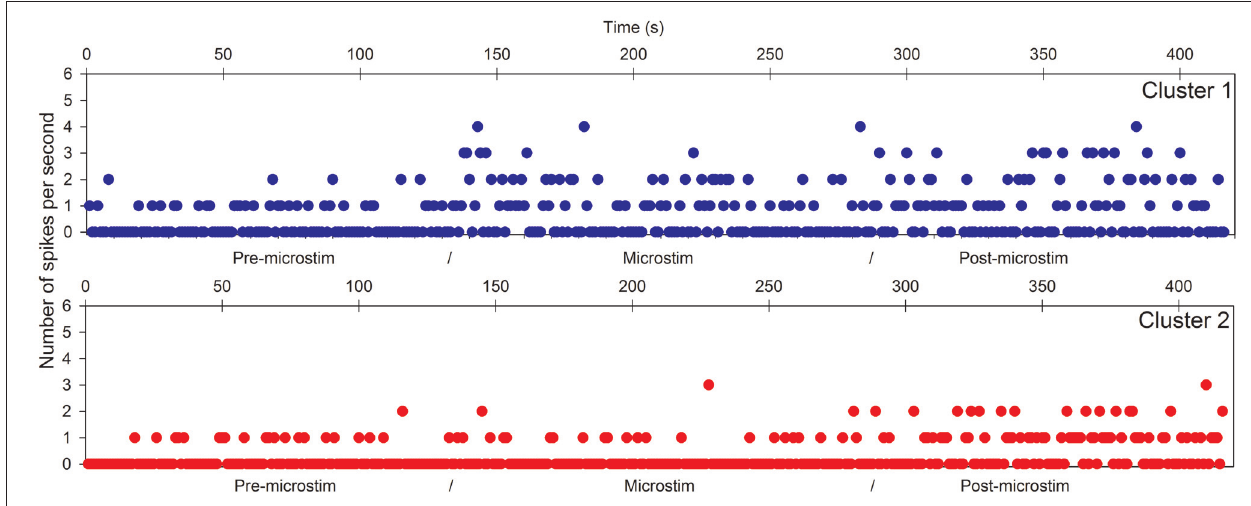
FIGURE 2 | Hippocampal microstimulation (patient H1, 1 Hz). Effects of microstimulation on spike frequencies illustrated with histograms of spike occurrences during the whole recording (ordinate: number of spikes per second, before, during and after microstimulation; time indicated in